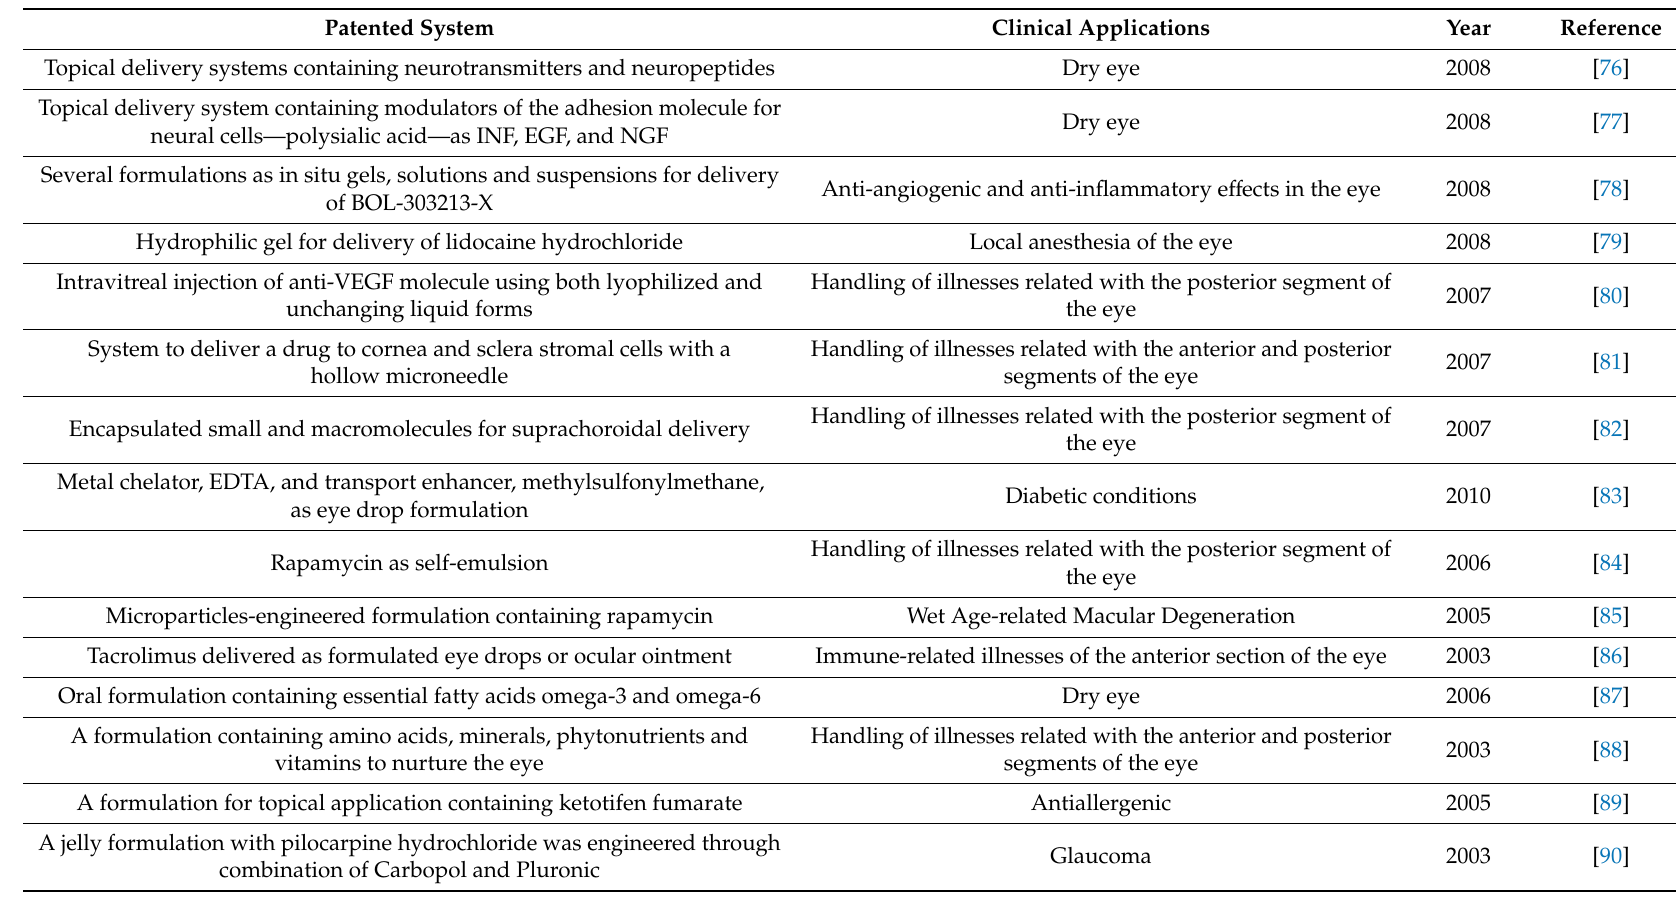
Table 3. Drug delivery systems for ocular